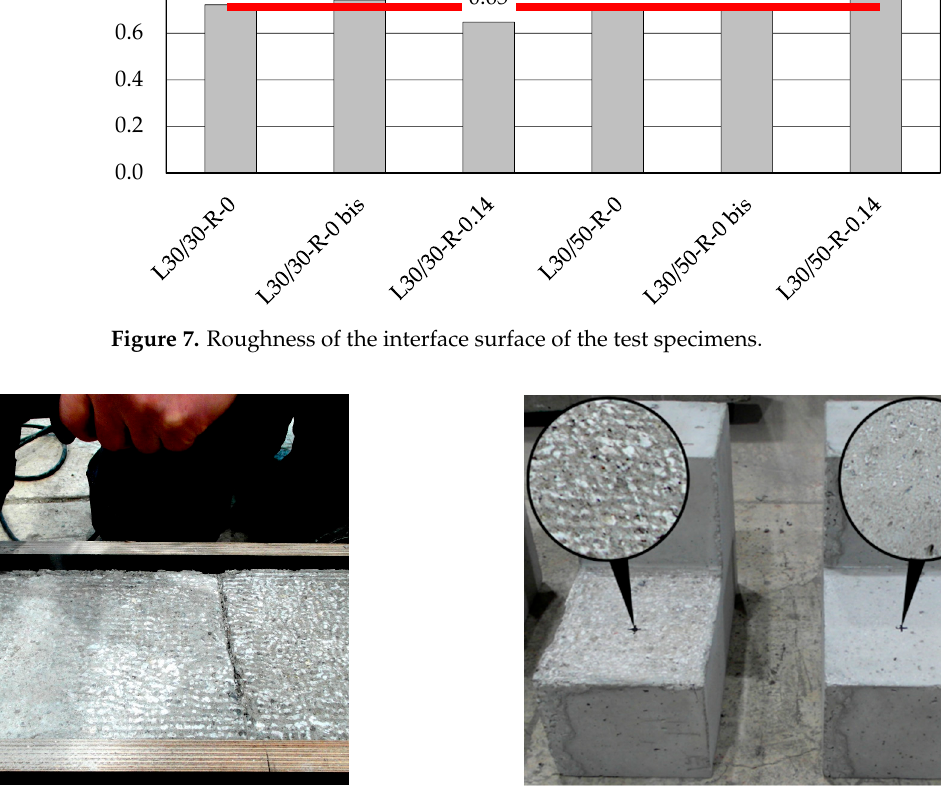
Figure 7. Roughness of the interface surface of the test specimens.